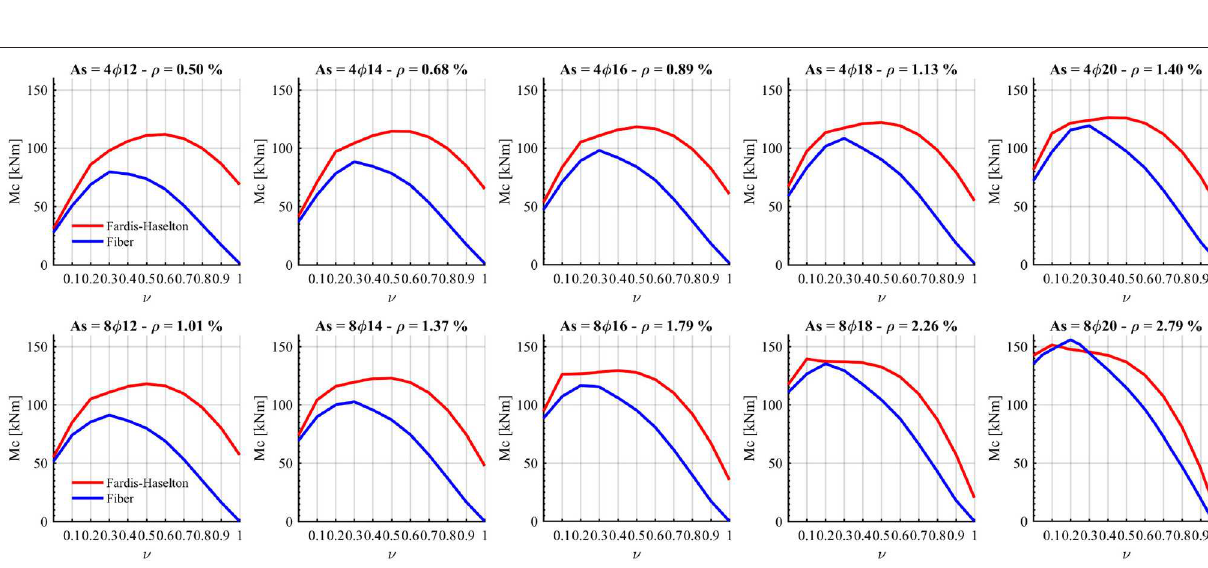
FIGURE 4 | Ultimate moment interaction obtained with Haselton et al. (2008) predictive equation and the fiber section.